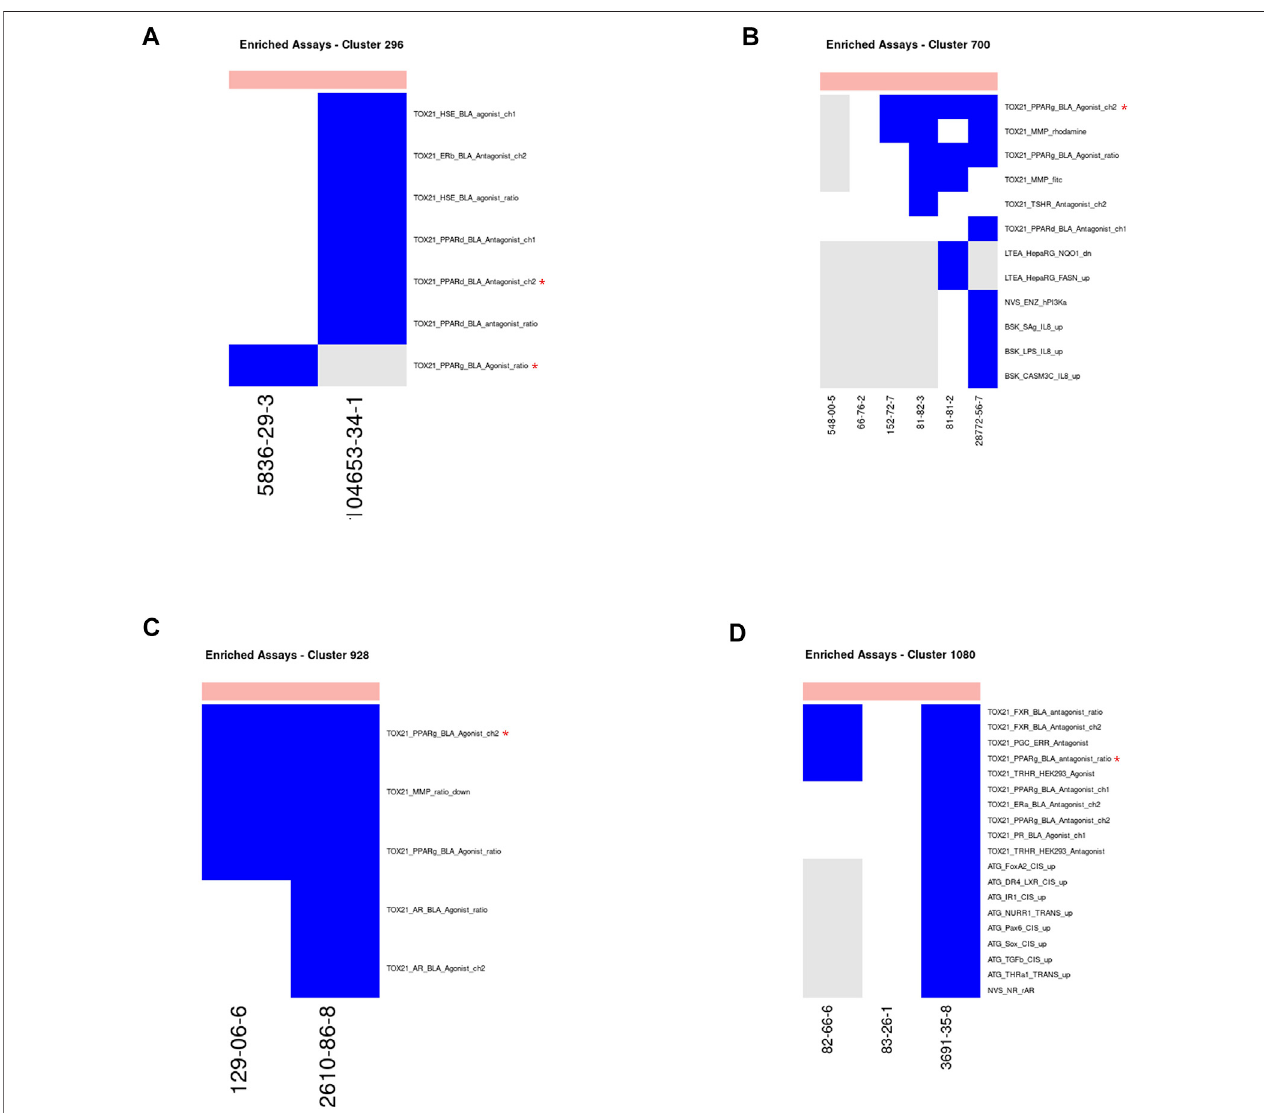
FIGURE 9 | Vitamin-K epoxide reductase inhibitors. Heatmap showing activity below the cytotoxicity range in the assays that were enriched for clusters 296 (A) , 700 (B) ,928 (C) and1080 (D) .Onlychemicalswithactivityinatleastoneassayareshown.Heatmap colors:blue=activebelowthecytotoxicitypoint, lightblue=active abovethecytotoxicitypoint,white=inactive,grey=nottested.Topofheatmap:red=toxic,blue=nontoxic,aquamarine=unde fi ned.Redasterisksidentifytheassay(s) selected for that cluster.